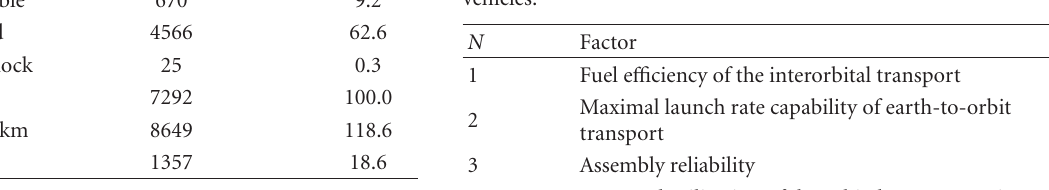
Table 5: Sources of the spending for the orbital assembly of the